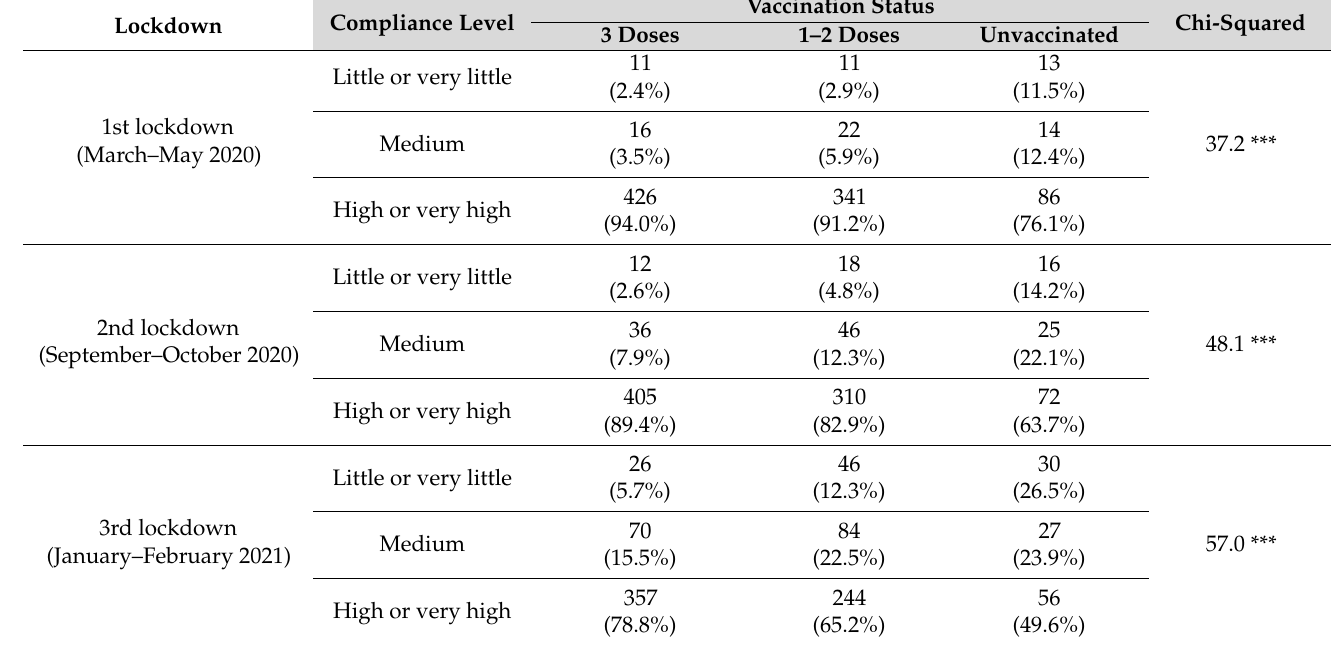
Table 2. Frequency ( N (%)) of reported compliance with lockdowns according to vaccination status ( N =